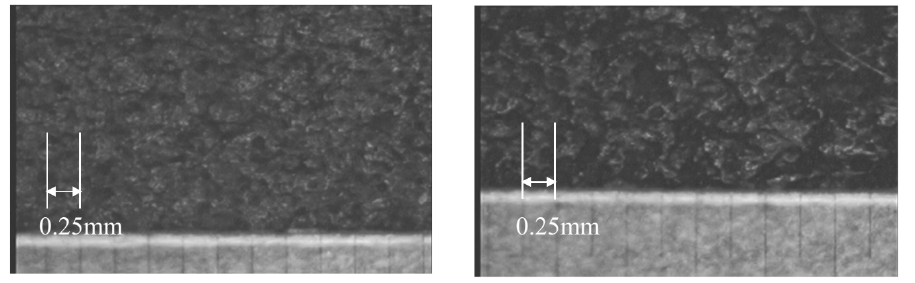
Figure 22. Surface photograph of the sample material coated with CNT spray paint (magnification: 100